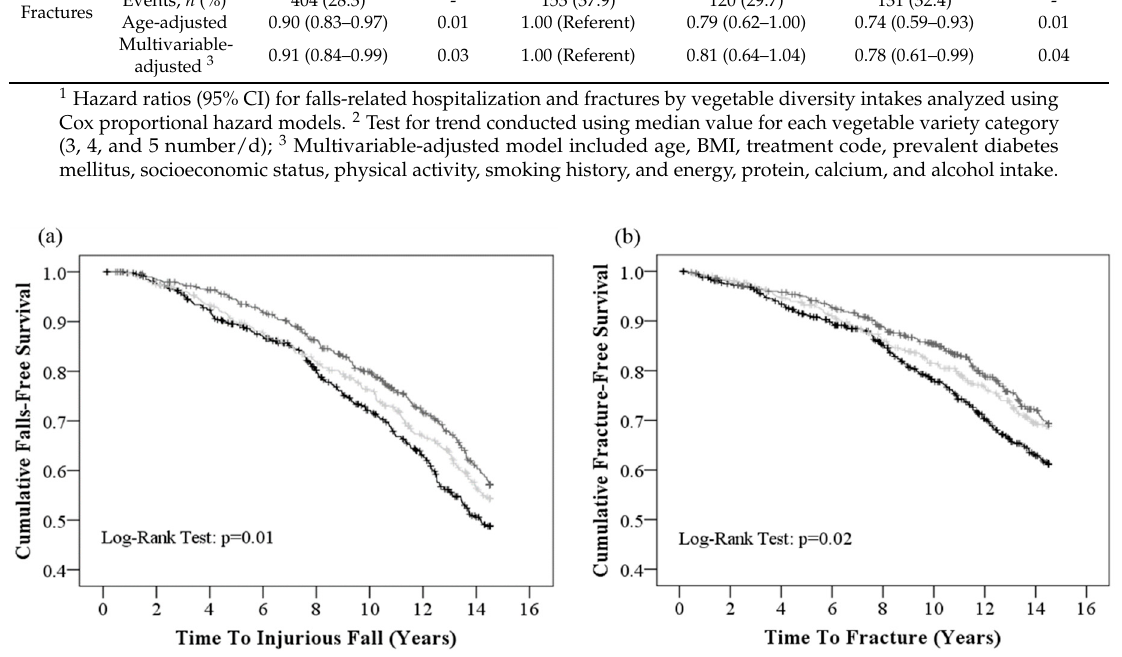
Table 2. Hazard ratios (HR) for injurious falls and fractures over 14.5 years by daily vegetable diversity intake categories 1 .